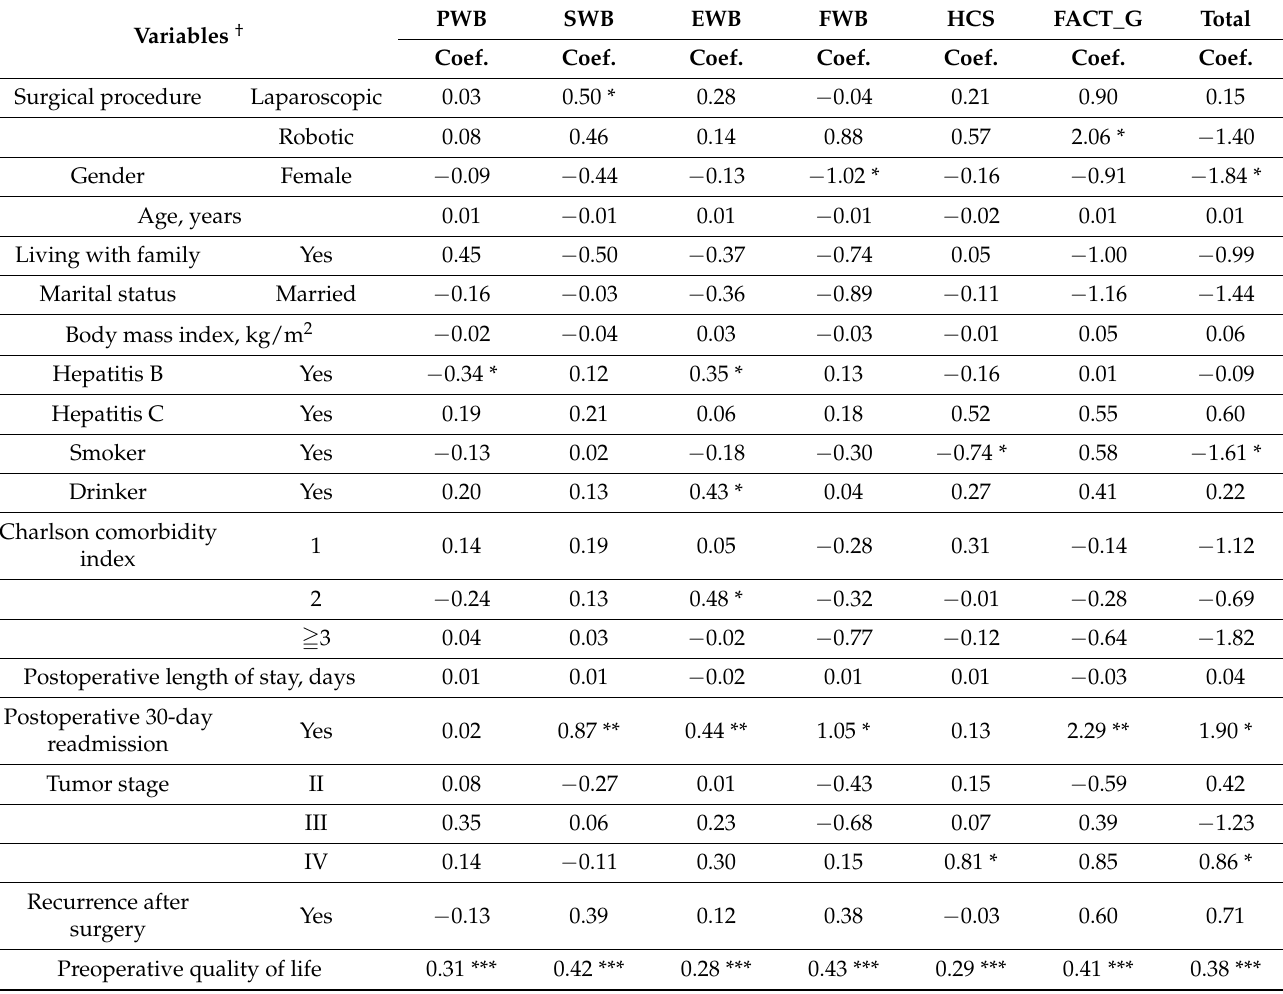
Table 2. Predictors of each Functional Assessment of Cancer Therapy-Hepatobiliary (FACT-Hep) subscale score after hepatocellular carcinoma surgery over a 5-year